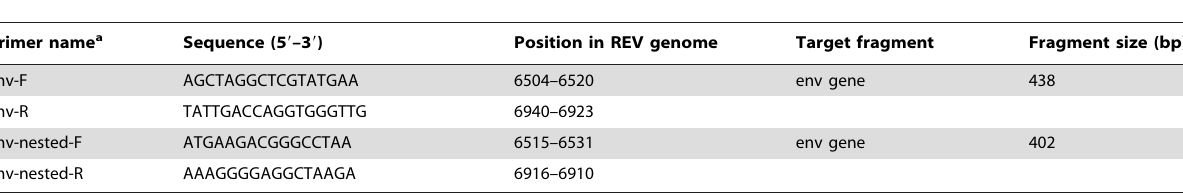
Table 3. List of primers used for amplification of REV env